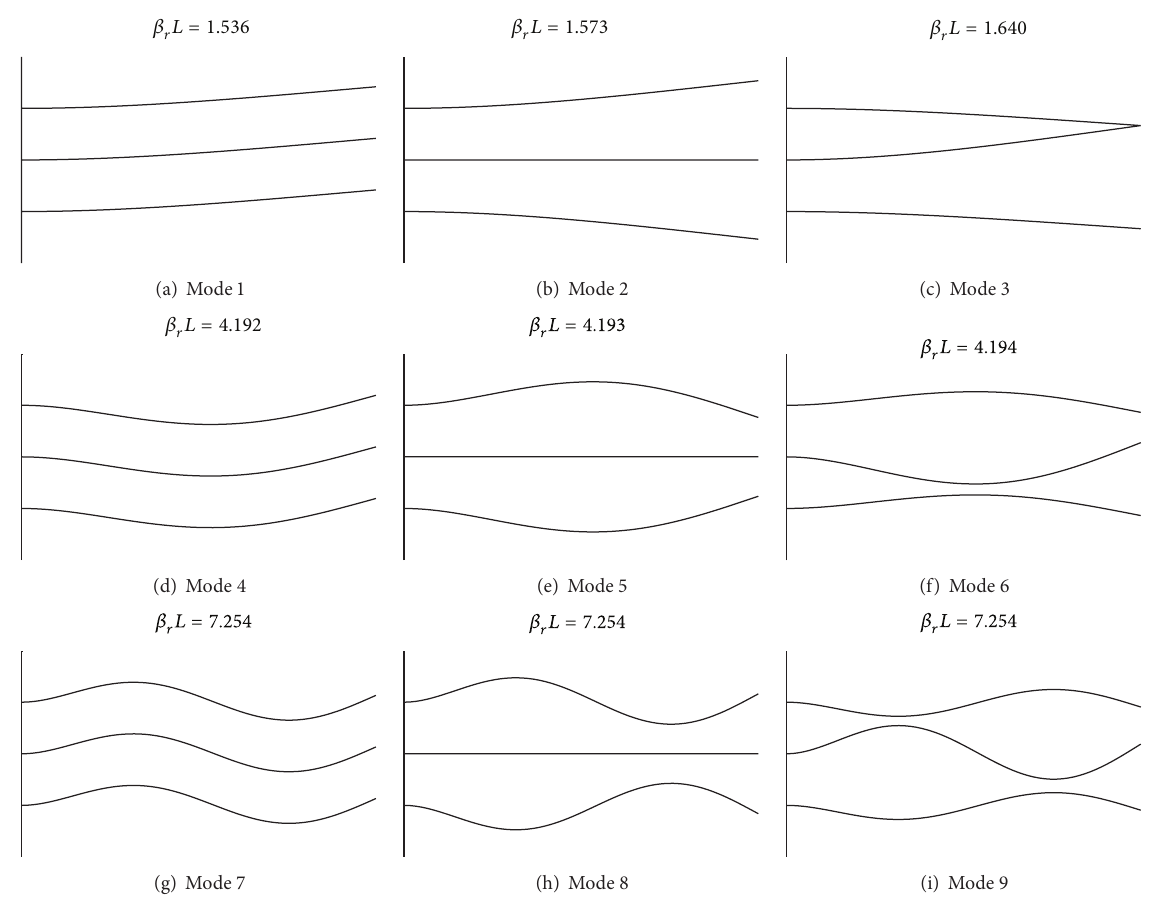
Figure 3: First nine vibration modes of three elastically connected beams with identical tip masses and spring constants ( 𝑀 𝑡,𝑖=1,...,3 = = 0.3𝐸𝐼/𝐿 3 ). 0.3𝑚𝐿, 𝑘 1,2